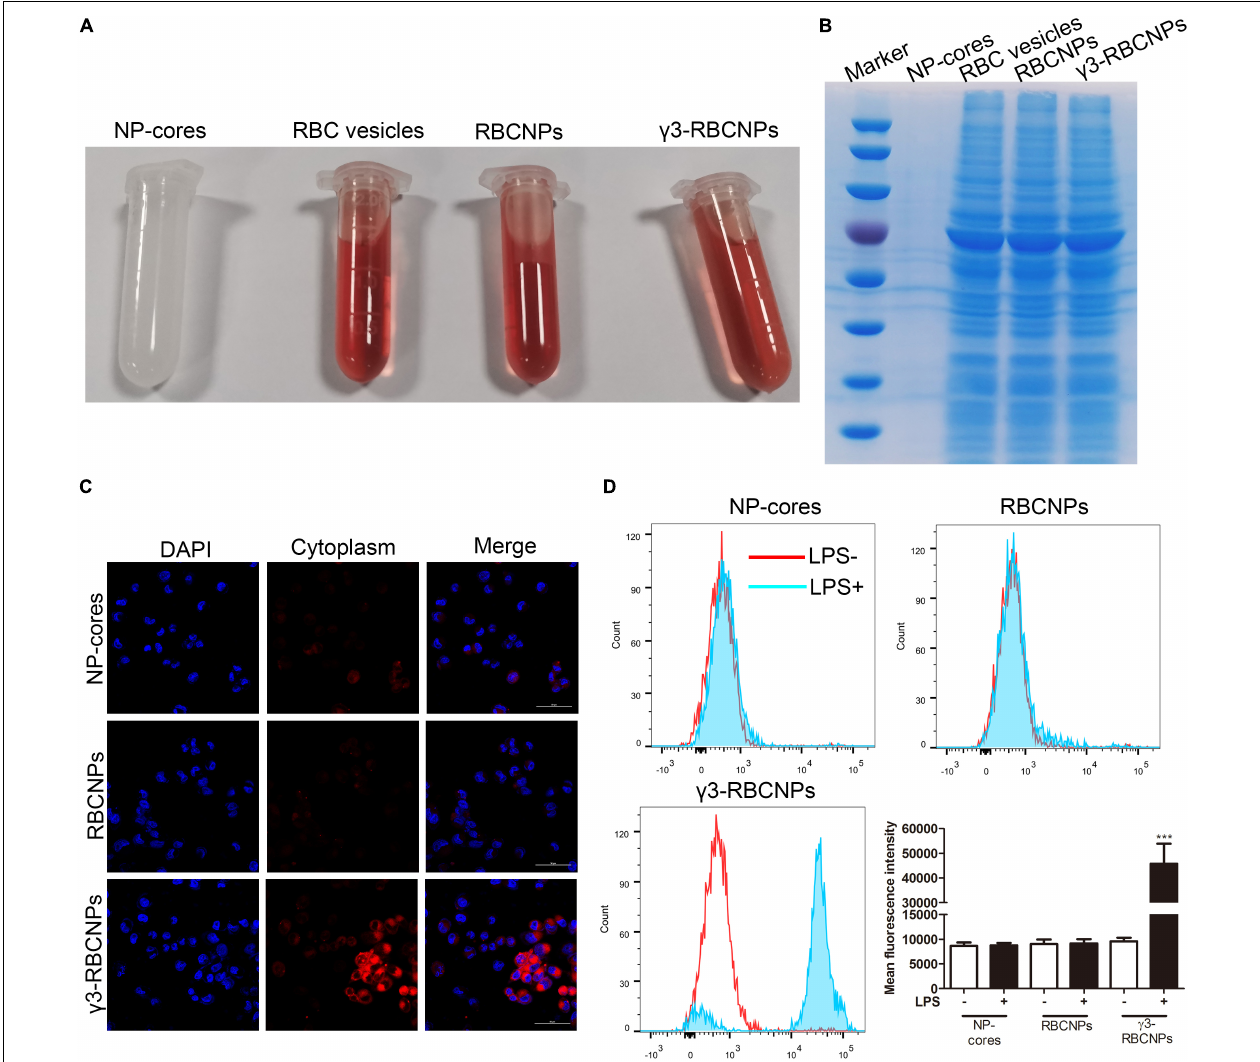
FIGURE 2 | Biological characteristics of γ 3-RBCNPs. (A) The appearance of the prepared NP-cores, RBC vesicles, RBCNPs, and γ 3-RBCNPs. (B) SDS-PAGE analysis of the membrane protein of RBC on the surface of NP-cores, RBC vesicles, RBCNPs, and γ 3-RBCNPs. (C) The targeting ability of NP-cores, RBCNPs, and γ 3-RBCNPs on TNF- α -stimulated HUVECs was evaluated with LSCM. Scale bar = 50 µ m. (D) The mean fluorescence intensity in HUVECs stimulated by LPS was assessed by flow cytometry. *** P < 0.001 vs. NP cores group.